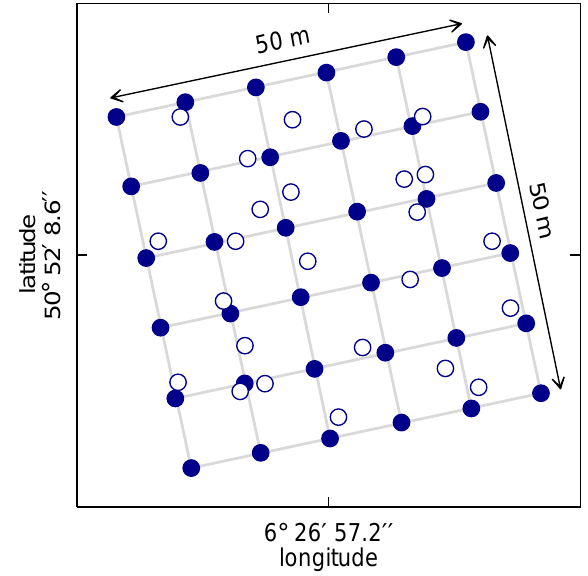
Fig. 1. Measurement grid with 61 measurement points used to ob- tain spatial averages of soil water content. Solid circles indicate 36 measurement points located on a regular 10m × 10m grid. Open circles denote 25 measurement points used for local refinement of the measurement grid. The refinement points were located such that each box of the regular 10m × 10m grid contained one randomly selected